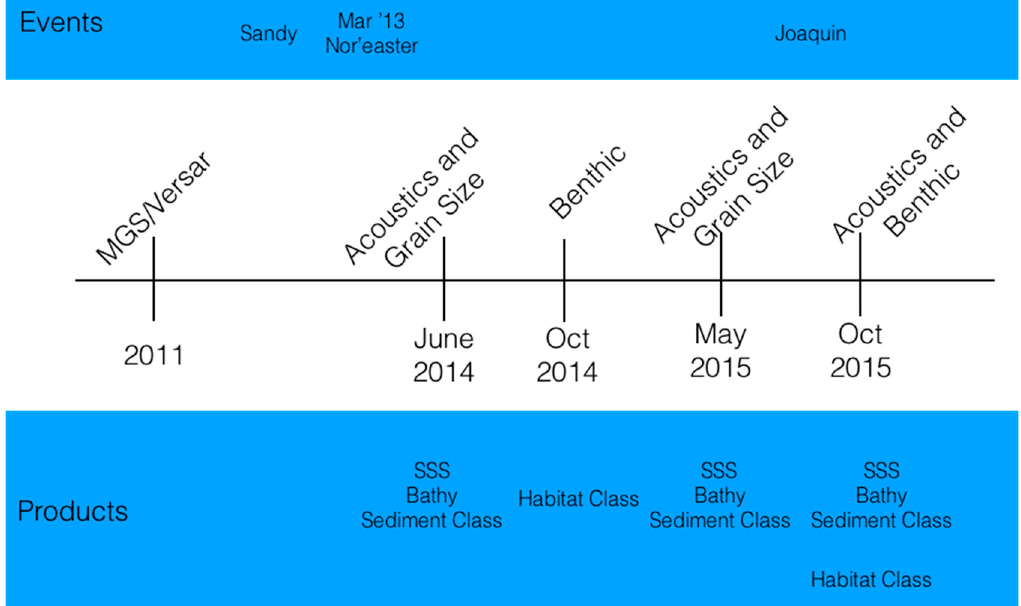
Figure 25. Timeline of Storm events and seafloor mapping studies and resulting benthic habitat and morphology products.